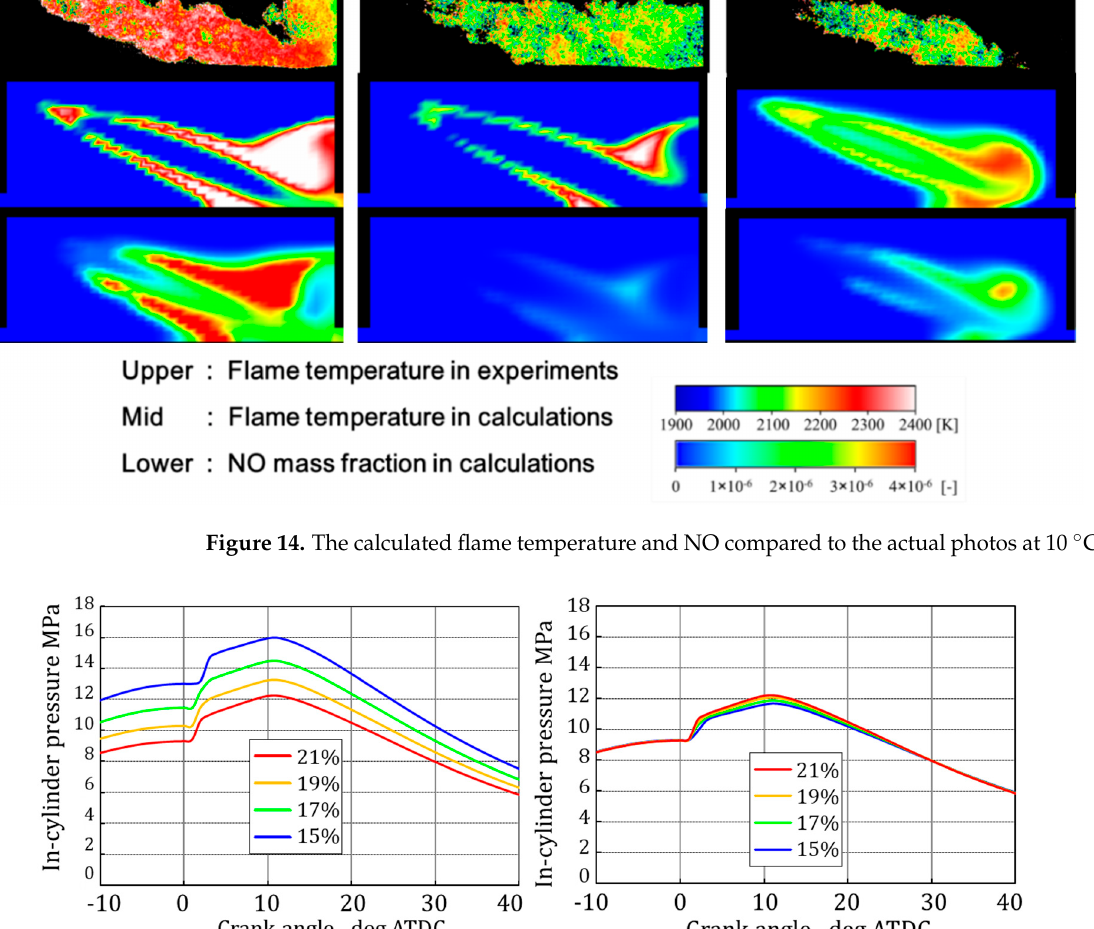
( b ) Figure 16. Experimental heat release rate versus crank angle for the two applied cases: ( a ) EGR and ( b ) WFEs. Figure 17 shows the NOx emissions concentrations in the exhaust gas for the different EGR–WFE combination cases based on the experimental results. Generally, applying the